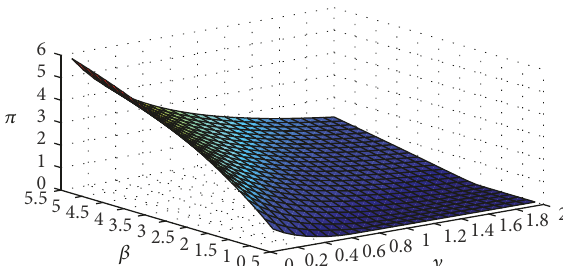
Figure 3: Variation of the present economic burden/premium ( 𝜋 ) with respect to rate of contact ( 𝛽 ) and 𝛾 . Here 𝛿 = 0.05 .